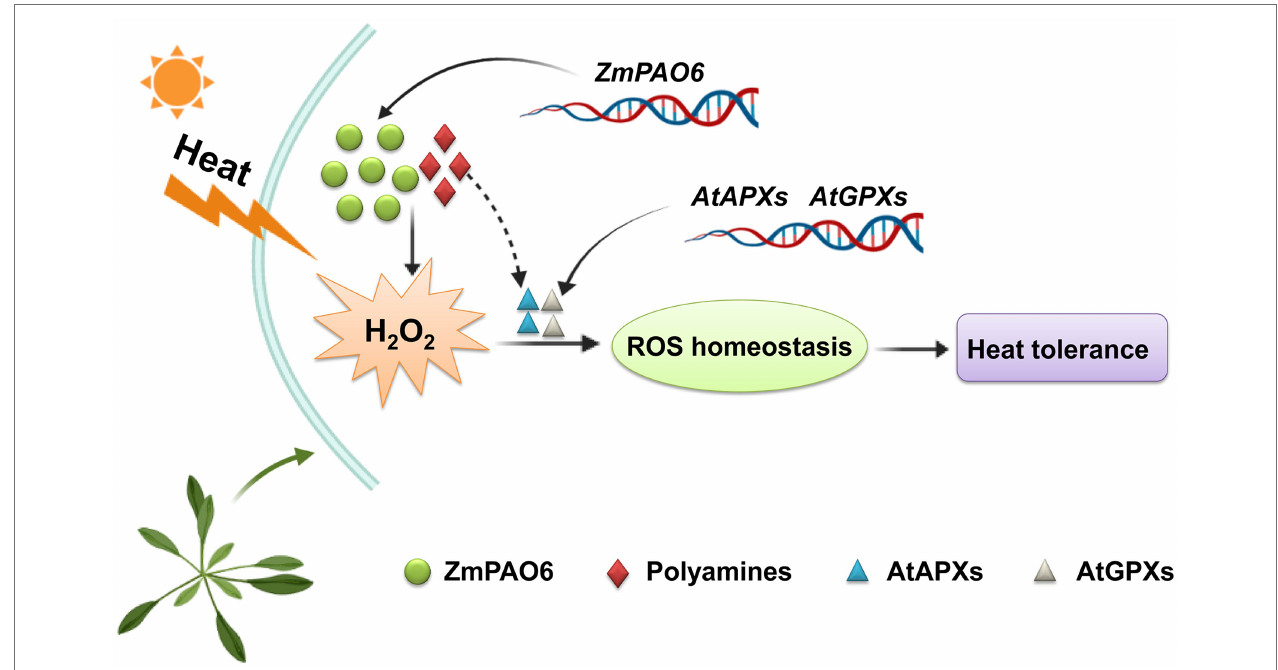
FIGURE 12 | A model for the role of the ZmPAO6 gene under heat stress in transgenic Arabidopsis